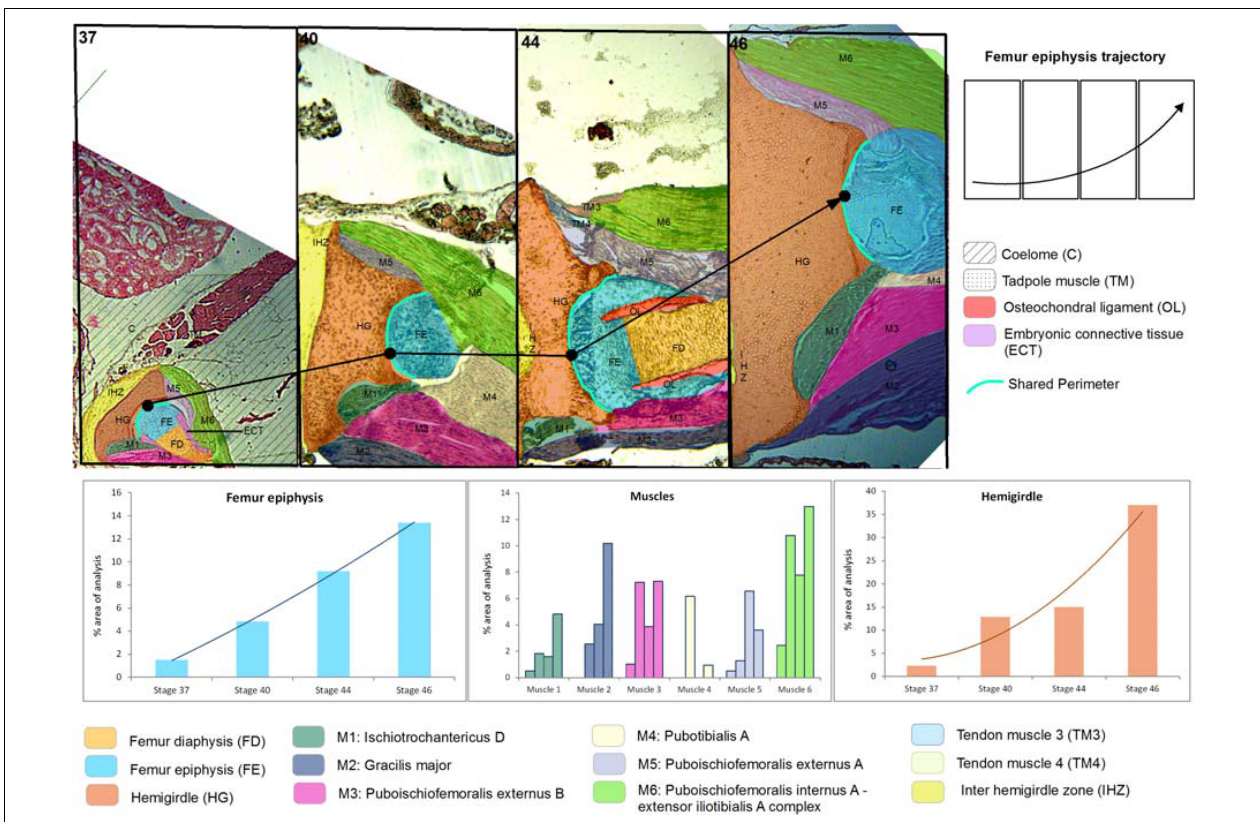
FIGURE 1 | Lisapsus limellum . Selected area and the ontogenetic Stages 37–46 showing the increase in size and change of location of pelvic girdle tissues and structures. In the frequency histograms the growth of the structures is